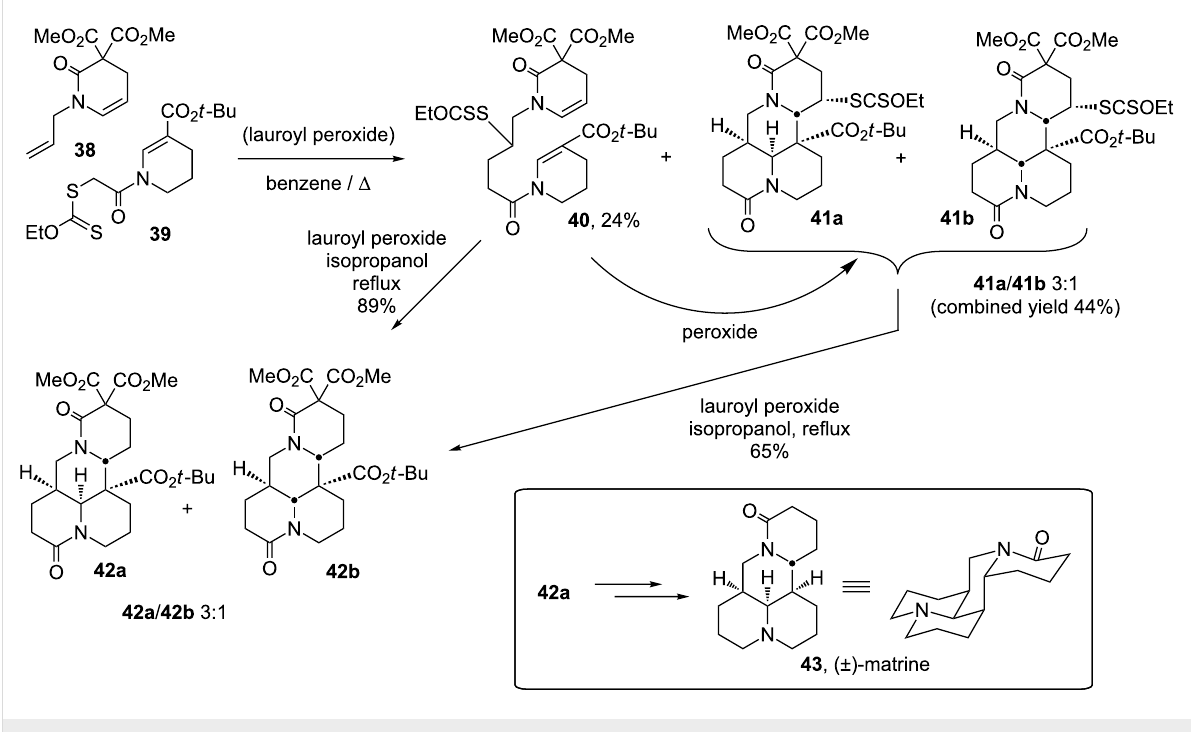
Scheme 9: Key cascade in the total synthesis of (±)-matrine ( 43